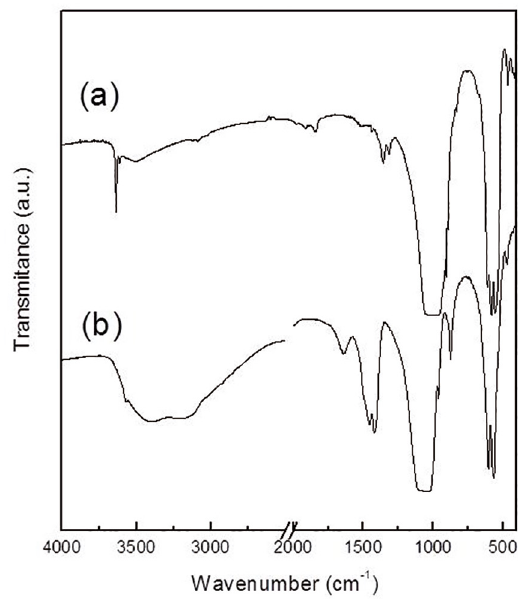
as β-Tricalcium Phosphate − β-TCP (ICDD, 9-169). The appearance of this phase indicates that the precipitated powder was a calcium-deficient Hydroxyapatite (d-HA).